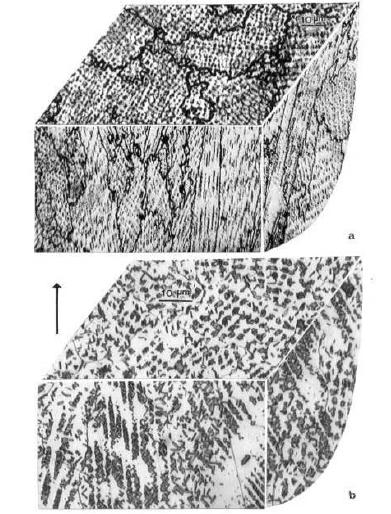
Figure 3. 3D microstructure composition views for ( a ) Co-Cr-Mo and ( b ) Ni-Cr-Mo-Nb mesh interiors oriented with respect to the build direction (arrow).